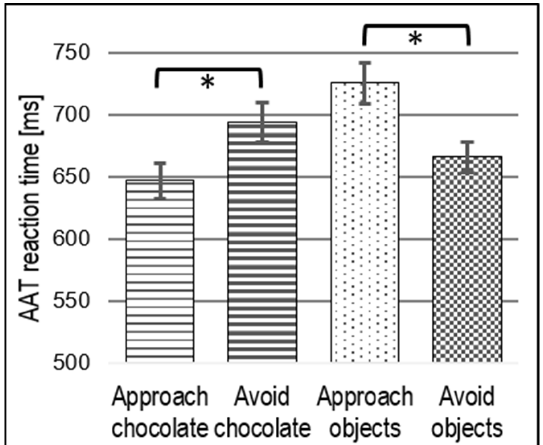
Figure 2. RTs for each AAT condition indicating a general approach bias toward chocolate; * p <